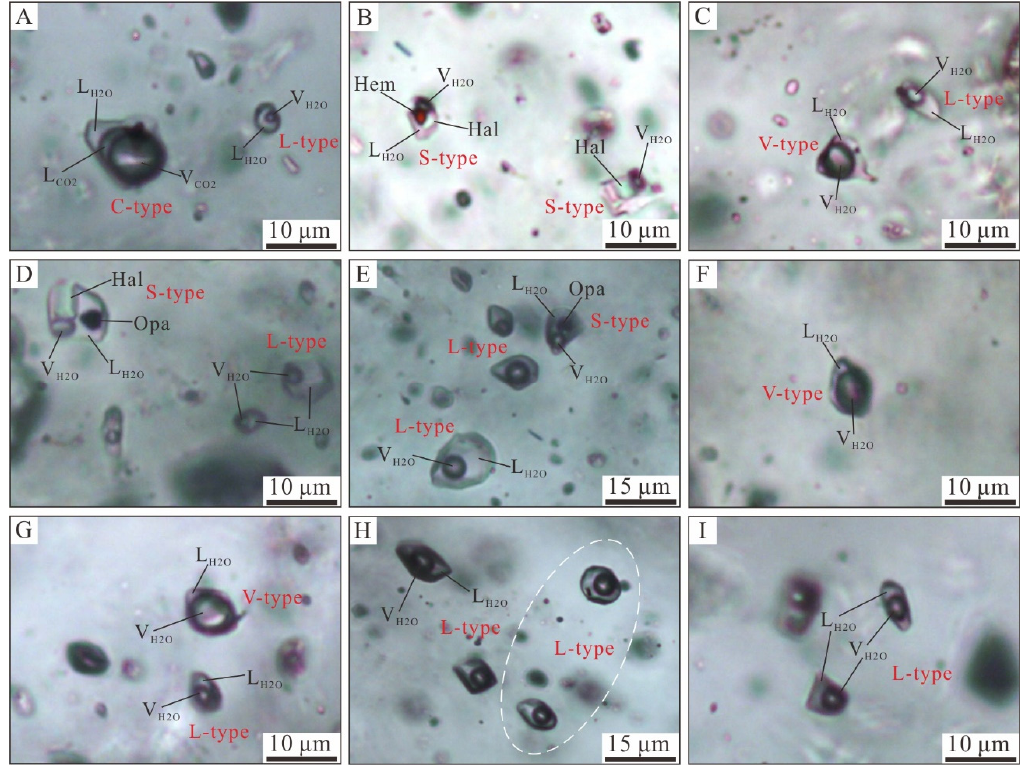
Figure 5. Photomicrographs of the representative primary FIs in four mineralization stages from the Huoluotai Cu (Mo) deposit. ( A ) The coexistence of primary L- and C-type FIs in stage I quartz. ( B ) S-type FIs with hematite and/or halite daughter minerals in stage I quartz. ( C ) The coexistence of primary L- and V-type FIs in stage I quartz. ( D , E ) The coexisting S- and L-type FIs in stage II quartz. ( F ) Primary V-type FIs in stage II quartz. ( G ) The coexisting L- and V-type FIs in stage III quartz. ( H ) Primary L-type FIs in stage III quartz. ( I ) Primary L-type FIs in stage IV quartz. Abbreviations: L H = 2 O H 2 O liquid; V H = H 2 O vapor; L CO = CO 2 liquid; V CO = CO 2 vapor; Hal = halite; Hem = hematite; 2 O 2 2 Opa = unidentified opaque